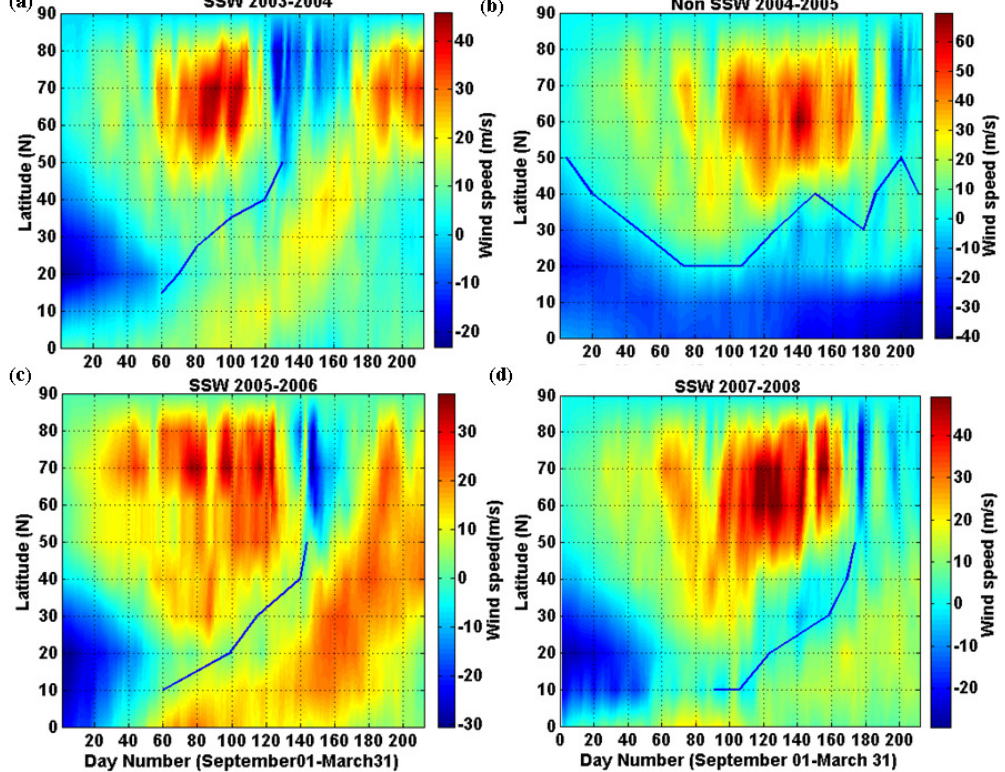
Fig. 3. The time variation of the zonal-mean zonal wind from equator to North Pole during the SSW years of (a) 2003–2004, (c) 2005–2006 (d) 2003–2004 and non SSW year (b) 2003–2004. The zero wind line is plotted in each figure as the blue